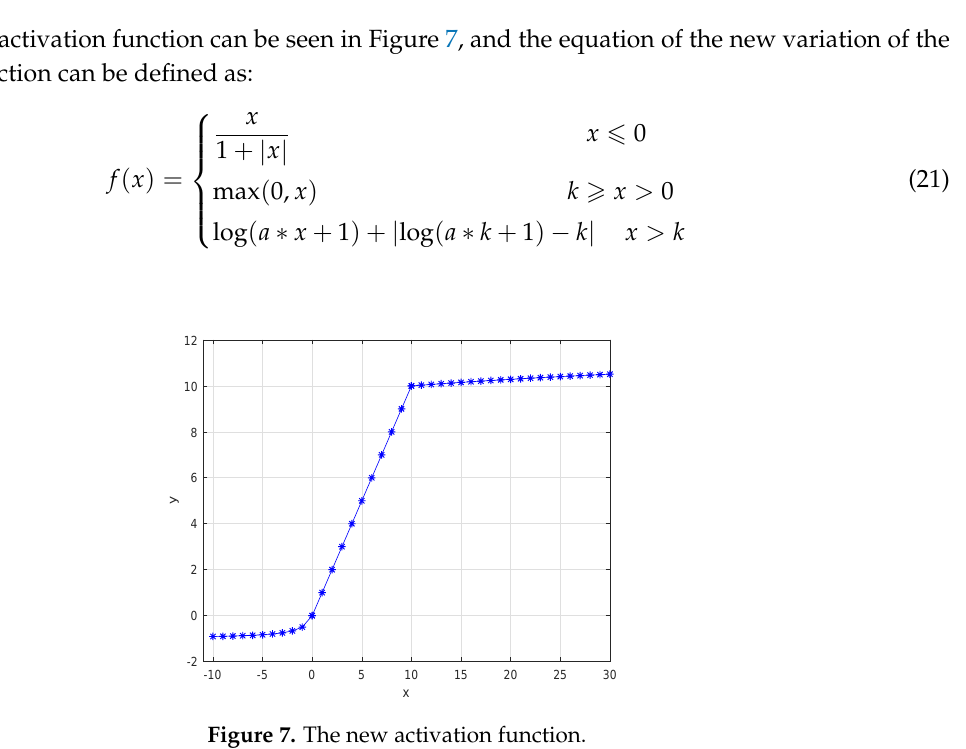
Figure 6. The curve of the softsign function. ( a ) The curve of the original function. ( b ) The derivative curve of softsign function in the negative-half axis.